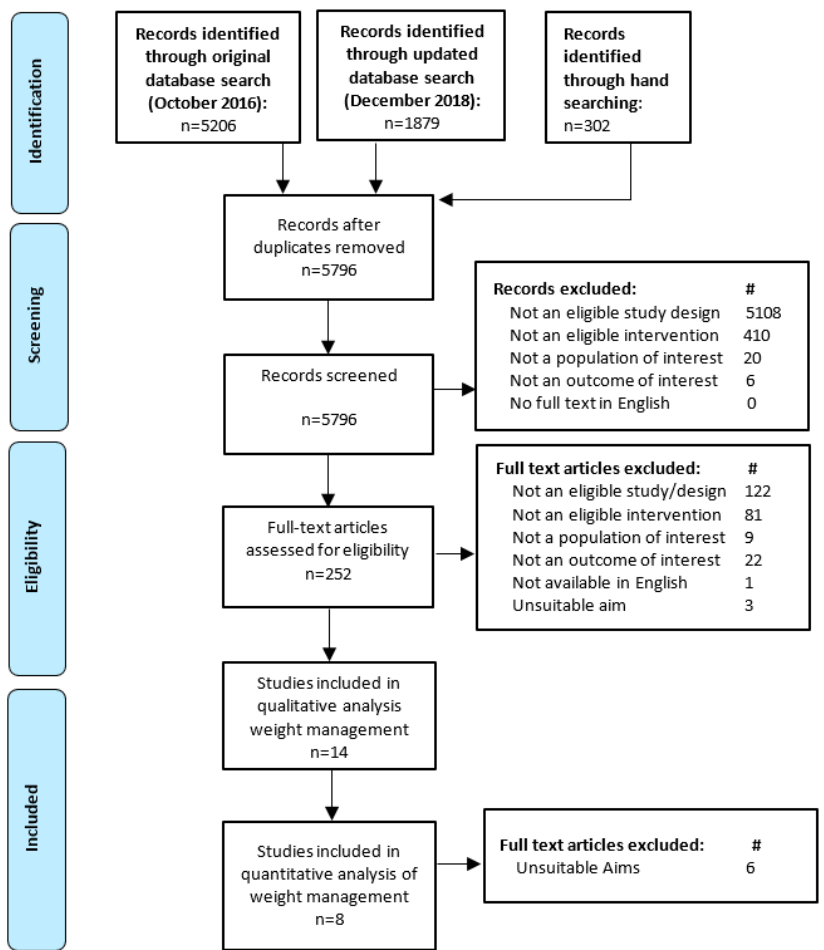
Figure 1. Flow diagram of the literature search and filtering results for a systematic review of the effectiveness of individual dietetic consultations for managing effectiveness of individual dietetic consultations for managing weight.